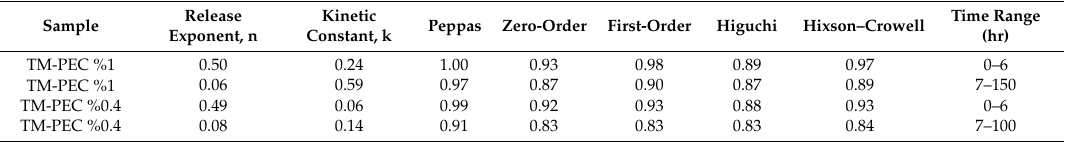
Table 4. Parameters of release mechanism and regression coe ffi cients of di ff erent models fitted to the release of thyme oil.